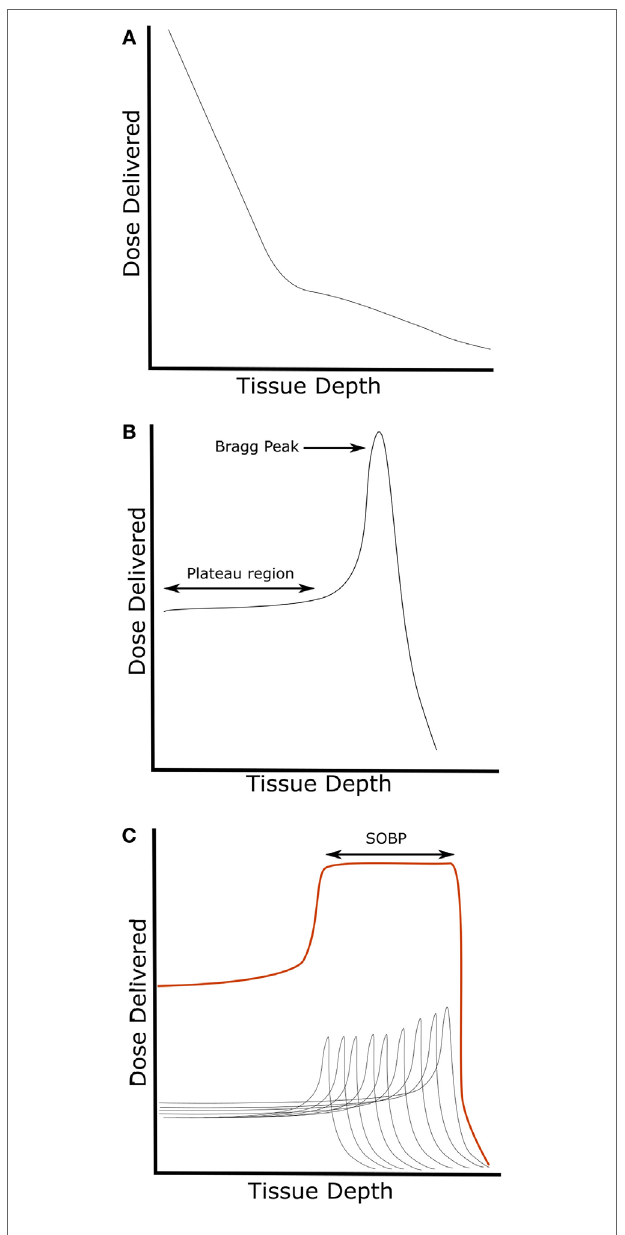
FiGURe 1 | Representative dose delivery patterns of (A) low-LET photons and (B) charged particles. (B) Charged particles demonstrate a low-LET plateau region before the high-LET Bragg peak. (C) Exposures with varying initial energies (gray lines) can be used to create a SOBP (red line) and cover the entire volume of targeted tissue with approximately the same dose of radiation. Abbreviations: LET, linear energy transfer; SOBP, spread-out Bragg peak.